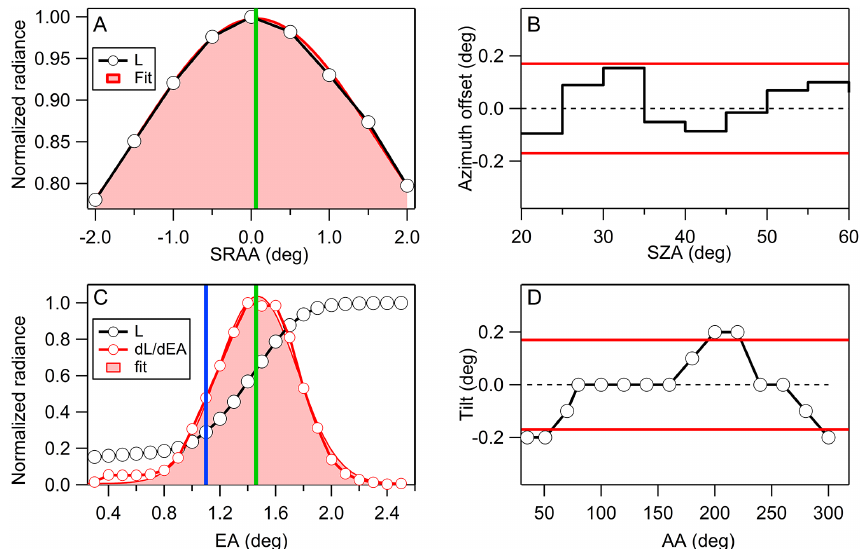
Figure 2. Alignment and characterization of pointing accuracy. (a) The AA is adjusted using the moving sun as absolute target. The AA is adjusted until symmetry is found in the aureole flux towards the left and right side of the sun. A Gaussian fit shows the center of the sun is offset by 0.06 ◦ (green line). (b) The azimuth offset (difference between azimuth of maximum aureole radiance and the absolute solar AA in Euler coordinates) is determined under clear skies as a function of SZA; the accuracy is always better than the resolution of the internal motor encoder (1 encoder step = 0.17 ◦ , red lines), and the absolute average is 0.08 ± 0.04 ◦ . This particular example was performed during the Two-Column Aerosol Project (TCAP, http://campaign.arm.gov/tcap/). (c) The EA offset is derived using a remote target (upslope hill) located at the solar azimuth angle of 242 ◦ . The black circles are the normalized fluxes, and the red circles are the derivative of the radiances as a function of EA. The theoretical geometric angle of the hill is 1.1 ◦ (blue line), and the EA obtained experimentally is 1.46 in this example (green line). (d) Tilt measured experimentally using a digital level (red lines; see